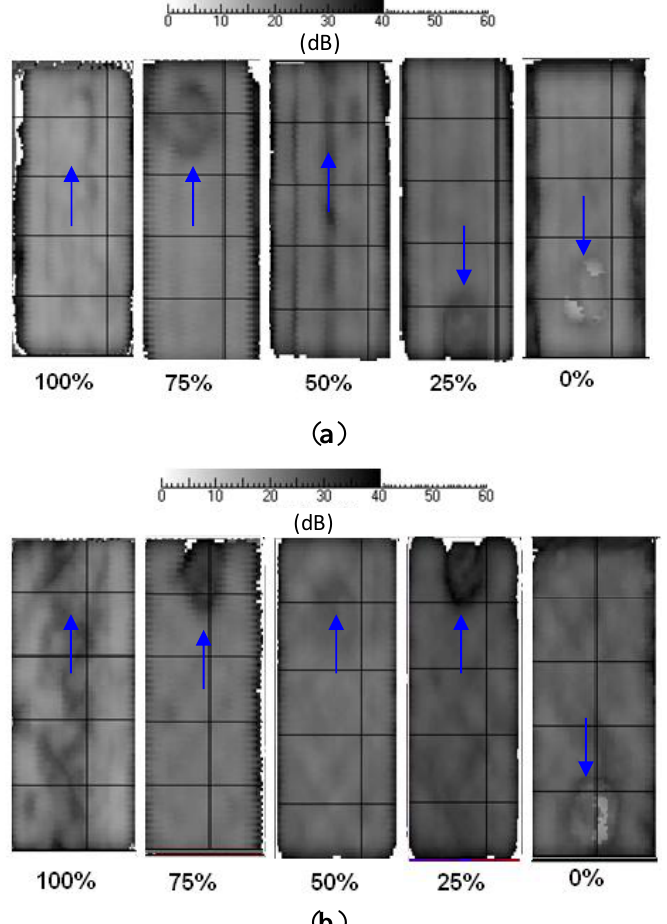
Figure 4. Attenuation c-scans for different P arrow indicates the position of the Kapton disk in each